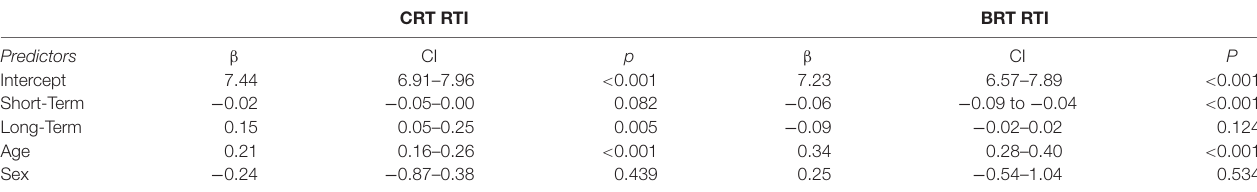
TABLE 2 | Fixed effects for CRT and BRT three-level multilevel